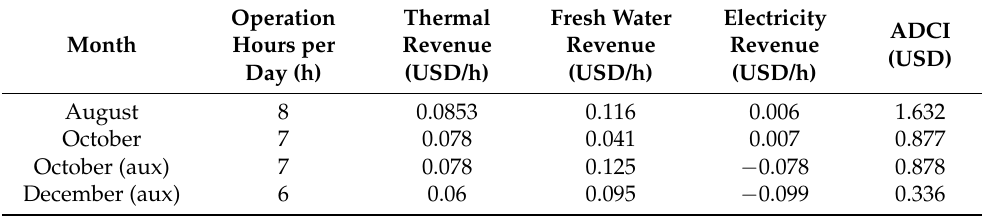
Table 3. Daily comprehensive income of LCPV/T-VMD system in different